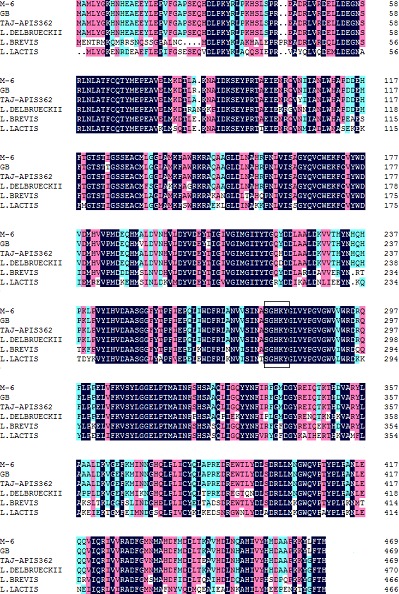
Multiple alignment of GAD from Lactobacillus plantarum M-6 and other GAD proteins.Amino acid sequences of GAD from L. plantarum M-6 (M-6), L. plantarum GB 01-21 (GB, GenBank accession no. AEL29212), L. plantarum Taj-Apis362 (Taj-Apis362, AHG59384), L. delbrueckii subsp. bulgaricus ATCC 11842 (L. delbrueckii, AHX56283), L. brevis OPK-3 (L. brevis, AAZ95185), and Lactococcus lactis (L. lactis, WP_023164198) were analyzed using ClustalW (1.81). The box represents the PLP binding site.